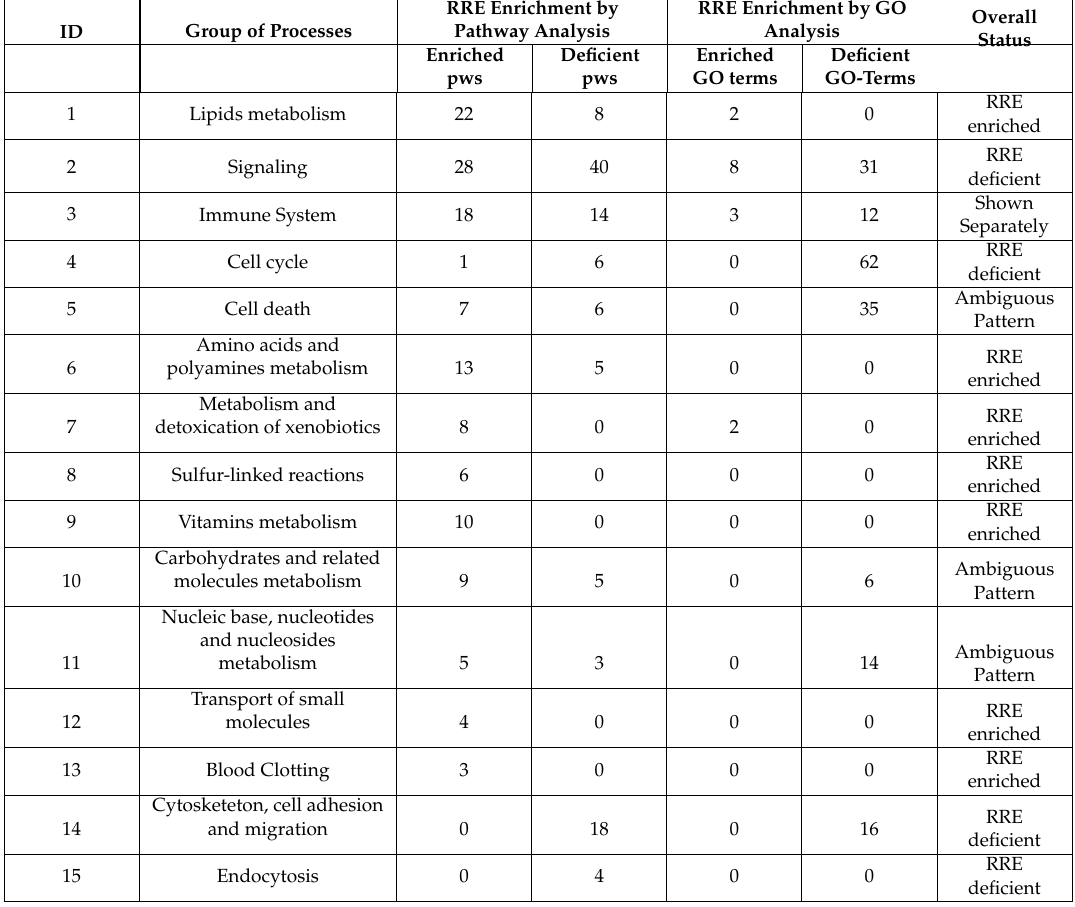
Table 6. RRE-enriched and deficient intracellular processes according to Gene Ontology (GO) and molecular pathway analysis ( evolutionary young